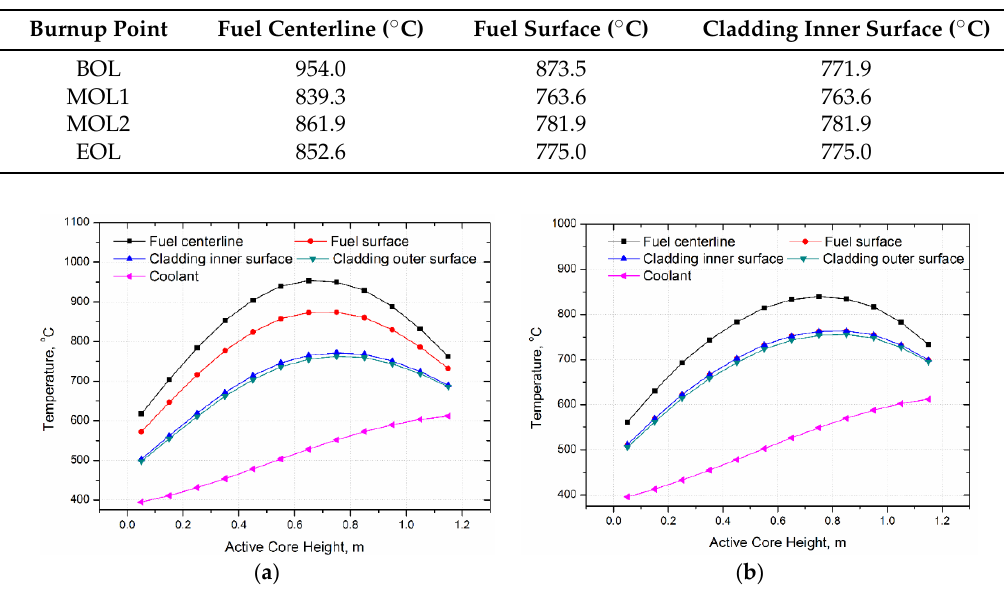
Figure 14. Hot channel temperature distributions of first ‐ half cycle MMR. ( a ) BOL of the first ‐ half cycle core; and ( b ) MOL1 of the first ‐ half cycle core.